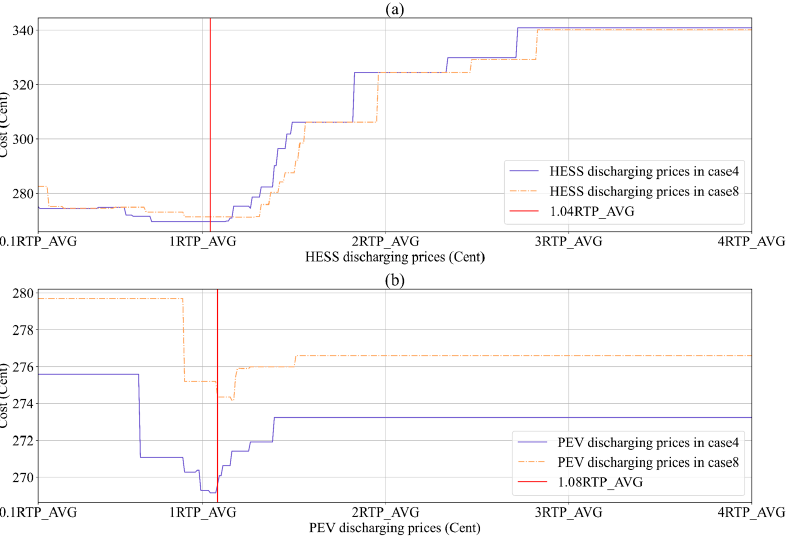
Figure 17. The impact of the discharge RTP threshold on the electricity cost for ( a ) HESS and ( b ) PEV.